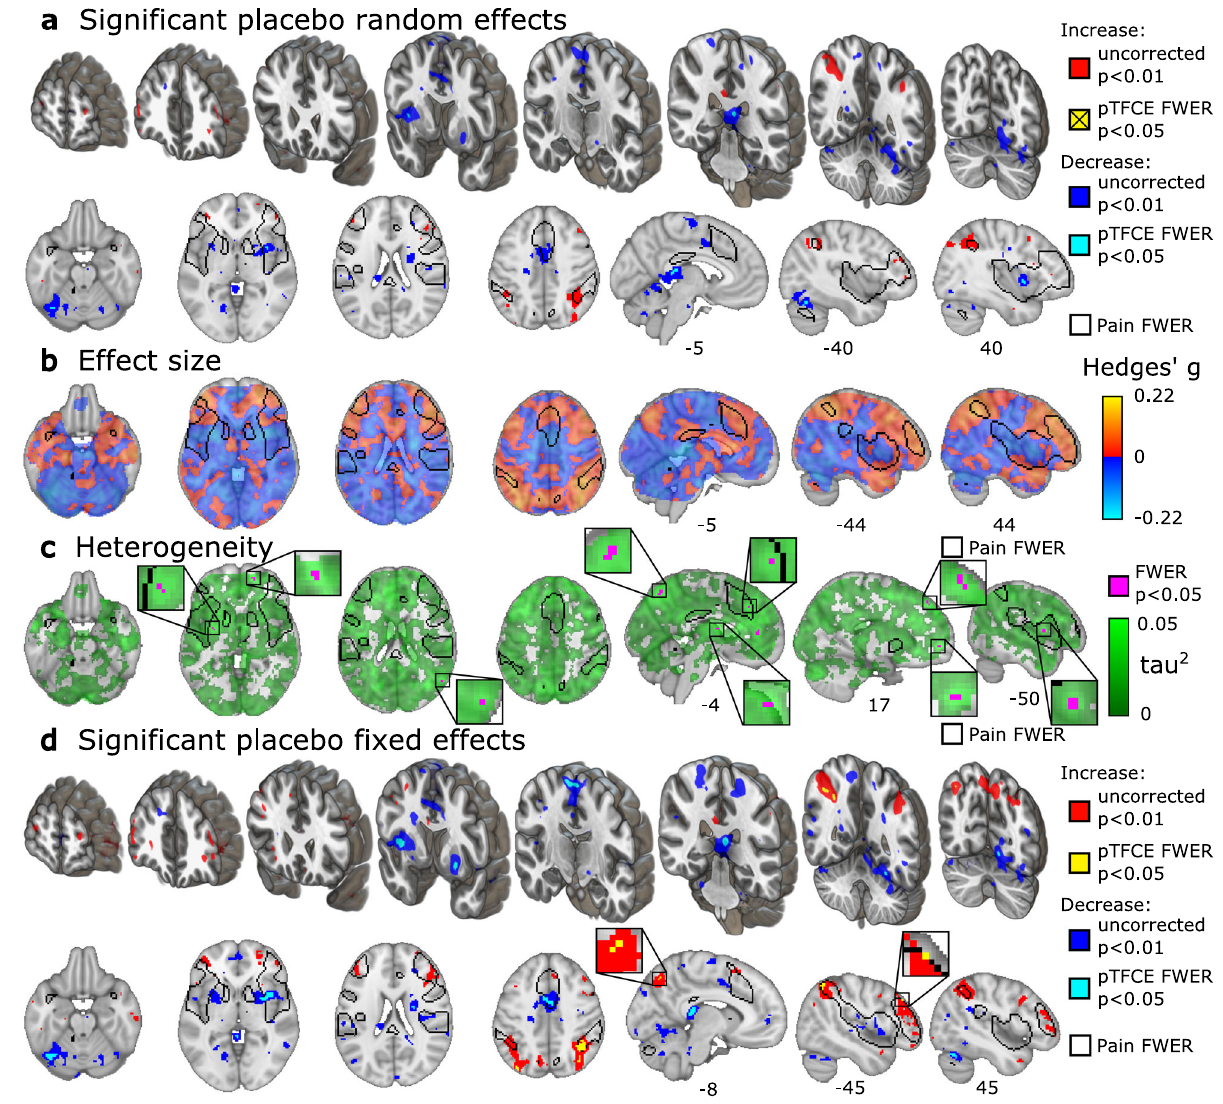
Fig. 2 Placebo-induced changes in pain-related activity. a Areas of statistically signi fi cant placebo treatment effect, assuming random study-effect, thresholded according to z- tests (uncorrected for multiple comparisons, two-sided p < 0.01, red and blue) and thresholded according to pTFCE-enhanced permutation test (controlled for FWER, two-sided p < 0.05, light blue, activity increases did not reach statistical signi fi cance); b unthresholded standardized effect size g of placebo treatment effect (range: [ − 0.19, 0.17]); c between-study heterogeneity τ (range: [0, 0.43]) with permutation test results (controlled for FWER, one-sided, p < 0.05, green); τ is plotted as τ 2 to emphasize regions of high heterogeneity. d signi fi cant placebo-effects assuming fi xed study-effect (range: [ − 0.22, 0.22]) thresholded according to z- tests (uncorrected for multiple comparisons, two-sided p < 0.01, red and blue) and thresholded according to pTFCE-enhanced permutation test (controlled for FWER, two-sided p < 0.05, light blue and gold); all: n = 543 to 603 individuals from 17 to 20 independent studies per voxel. b , c , and d are shown with a contour of FWER-corrected permutation test results for pain > baseline, as shown in Fig. 1a. Small FWER-corrected clusters are zoomed in insets. Three-dimensional coronal slices are equidistantly distributed from y = 60 to − 68 mm. Axial slices range equidistantly from z = − 22 to 42 mm. Custom coordinates for sagittal slices are displayed in mm and were chosen to highlight important areas of activation. Source data (results as 3d-volumes) are provided at (Fig. 4, Column 2). These included activation in the ventral attention network (which encompasses the insulae), the fronto- parietal network 14 , and the somatomotor network. Positive associations were also found in all insular sub-regions and most thalamic nuclei, including the intralaminar nuclei targeted by ascending nociceptive pathways, the mediodorsal ‘ limbic asso- ciation ’ nucleus, and the ventro-basal complex, including the ventro-posterior lateral (VPL) nucleus 15 . A tendency towards negative associations was found for the lateral geniculate, medial geniculate, and pulvinar nuclei, which are known for their pre- dominantly visual and auditory roles 15 .